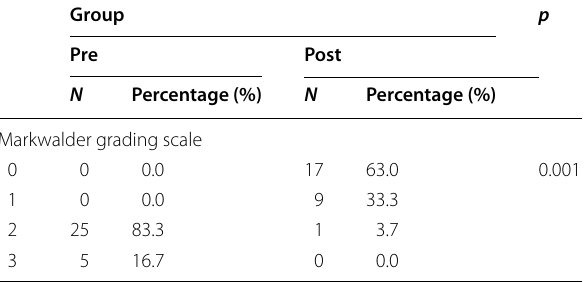
Table 5 Evaluation of Markwalder score preoperatively and